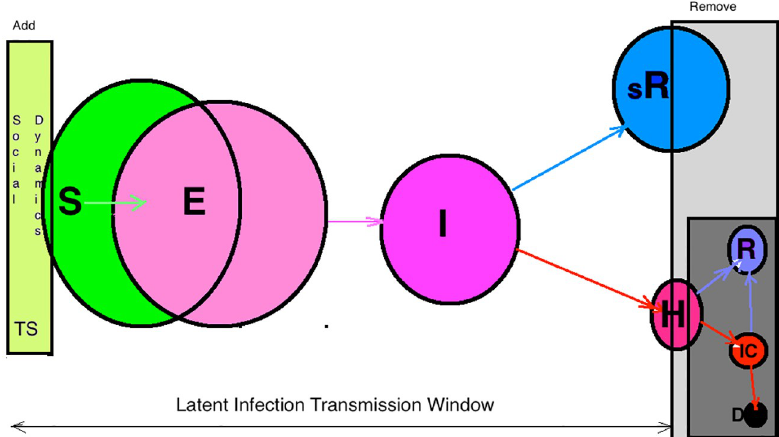
Fig 1. Different groups of agents and transition between them. In the simulation time window between the addition of agents through social dynamics time series and their removal by either spontaneous recovery or hospitalisation, are schematically indicated: “Susceptible” (S) ! “Exposed” (E) ! ”spontaneously- Recovered” (sR) or ! “Hospitalised” (H). For completeness, further differentiation of the “Hospitalised” group to “Intensive-Care” (IC), “Recovered” (R) and “Deceased” (D) groups are shown in the darker square on the lower right corner; these latter subgroups do not contribute to the dynamics studied in this work.